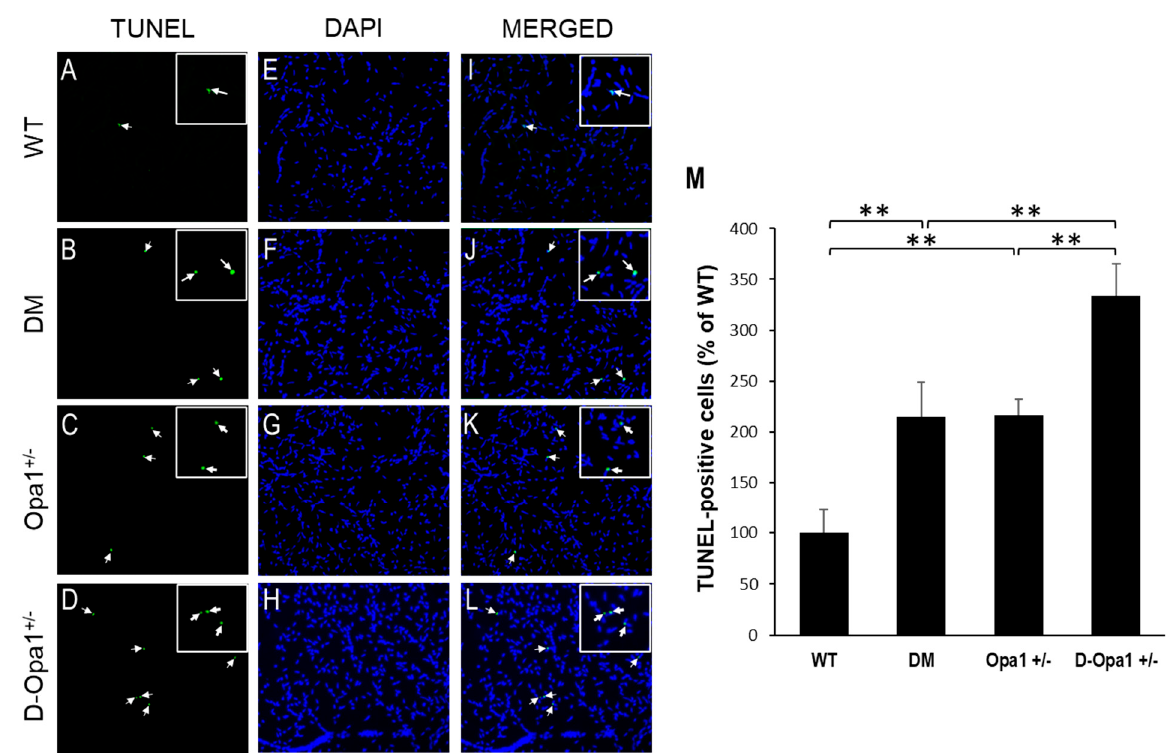
Figure 5. Reduced Opa1 level exacerbates diabetes-induced apoptosis of vascular cells in retinal capillary networks. Representative images show TUNEL-positive cells (arrows) in retinal capillaries of ( A ) WT mice, ( B ) diabetic (DM) mice, ( C ) Opa1 +/ − mice, and ( D ) diabetic Opa1 +/ − mice (D- Opa1 +/ − ). ( E – H ) Corresponding images of DAPI-stained cells in the retinal capillary networks, respectively. ( I – L ) Merged images show TUNEL-positive cells are superimposed with DAPI-stained cells; 20x magnification. Insets represent enlarged images of TUNEL-positive cells. ( M) Graph representing cumulative data shows increased number of TUNEL-positive cells in retinal capillaries of diabetic mice compared with that of WT mice, while retinal capillary networks of D- Opa1 +/ − mice show a further increase in the number of TUNEL-positive cells compared with that of diabetic mice. Data are presented as mean ± SD. ** = p < 0.05, n = 6.